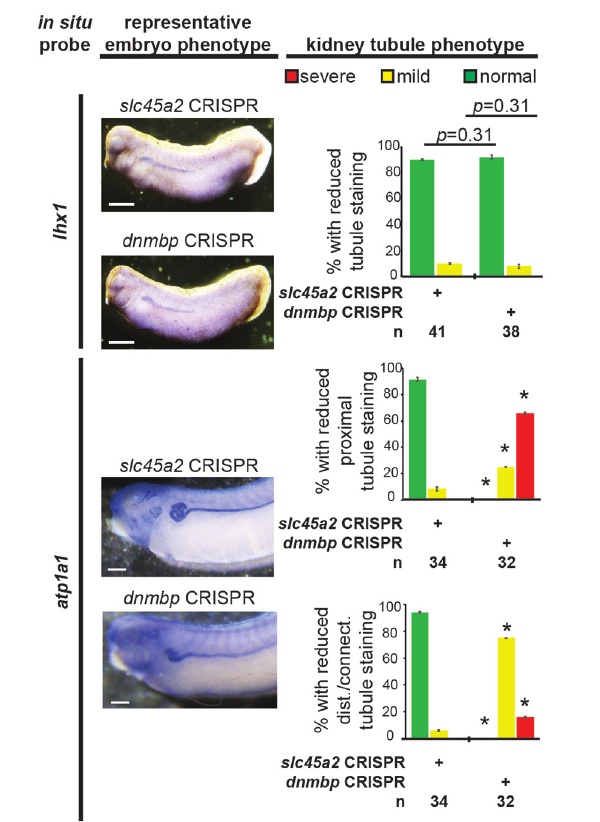
FIGURE 9 | dnmbp CRISPR knockout does not alter expression of early markers of kidney development, however late marker expression is altered by in situ analysis. Embryos injected unilaterally at the 8-cell stage (blastomere V2) to target the kidney and reared to stage 29–30 for lhx1 expression assessment and stage 40–41 for atp1a1 expression assessment. Representative embryo phenotypes shown. Scale bar indicates 500 µ m. n = number of embryos across 2 replications. Error bars represent Standard error. ∗ Significantly different from control, p <